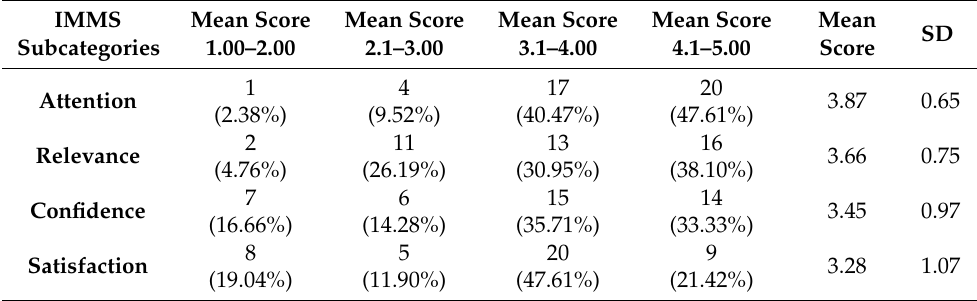
Figure 8. Comparison between the control and experimental group’s perceived motivational level. The overall means score, frequency, standard deviation, and percentage of the learner’s perception of motivation for the experimental group are presented in Table 5. The highest percentage (47.61%) of the mean score indicates that the majority of the participants have means score between 4.01 to 5.00, for the attention subcategory. The satisfaction subcategory also has the highest percentage (47.61%) for the means score between 3.1 to 4.0. The overall mean score of subcategories of the IMMS scale shows that participants have the high score in attention (3.87) followed by relevance (3.66). Table 5. Overall mean score, frequency, standard deviation, and percentage about the learner’s perception of motivation towards learning OOP using